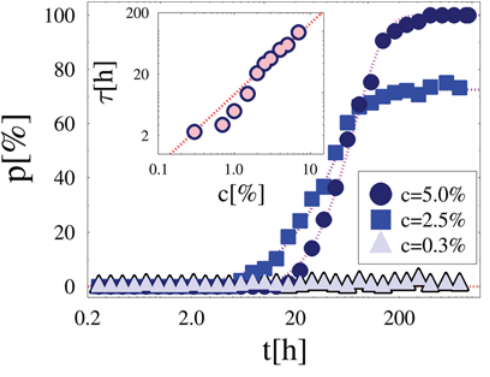
Figure 5. System Dynamics. The average fraction of paired chromosomes, p , is plotted as a function of time, t , for three values of the concentration of molecular factors, c (here E =1.2 kT ), belonging to three different regimes: Brownian c =0.3%; crossover c =2.5%; Pairing c =5%. After an initial diffusive behavior, chromosomes attain their equilibrium pairing state exponentially in time (superimposed fit: p ( t ) / [1 2 exp( 2 t / t )]). Inset: The average time scale, t , to attain the equilibrium pairing state is plotted as function of c (for E =1.2 kT ). t increases with c because the higher c , the higher is the average number of molecules bound to DNA and, consequently, proportionally lower the Xic diffusion constant. The superimposed fit is a linear function.